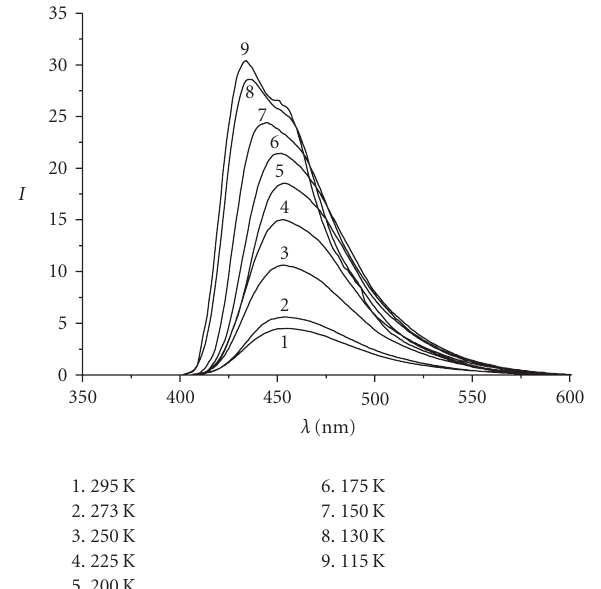
Figure 4: The fluorescence spectra of III in ethanol at di ff erent temperatures.